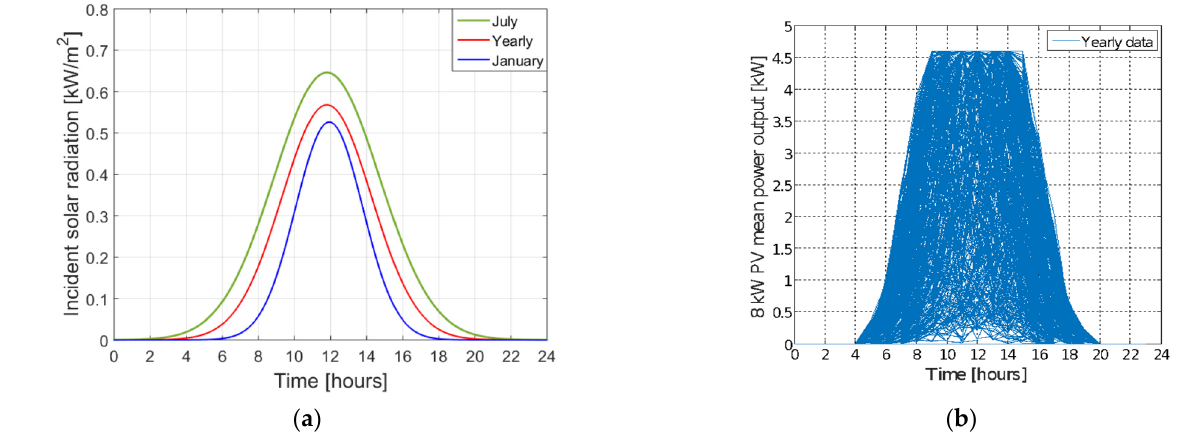
Figure 3. ( a ) Incident solar radiation comparison charts for the analyzed geographic area with Gaussian fitting function; ( b ) PV power daily traces cumulated; all for the 8 kW PV array.